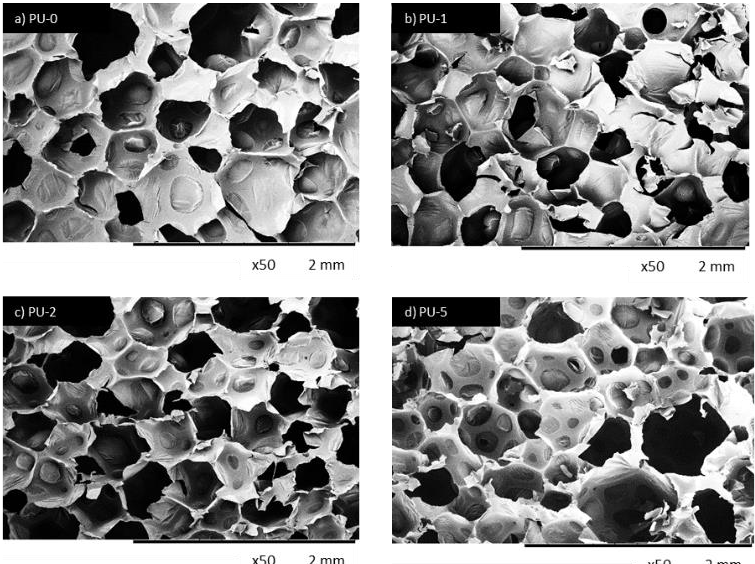
Figure 10. The cellular structure of ( a ) PU-0, ( b ) PU-1, ( c ) PU-2 and ( d ) PU-5 observed at a magnification of × 50. Adapted from Ref. [9].